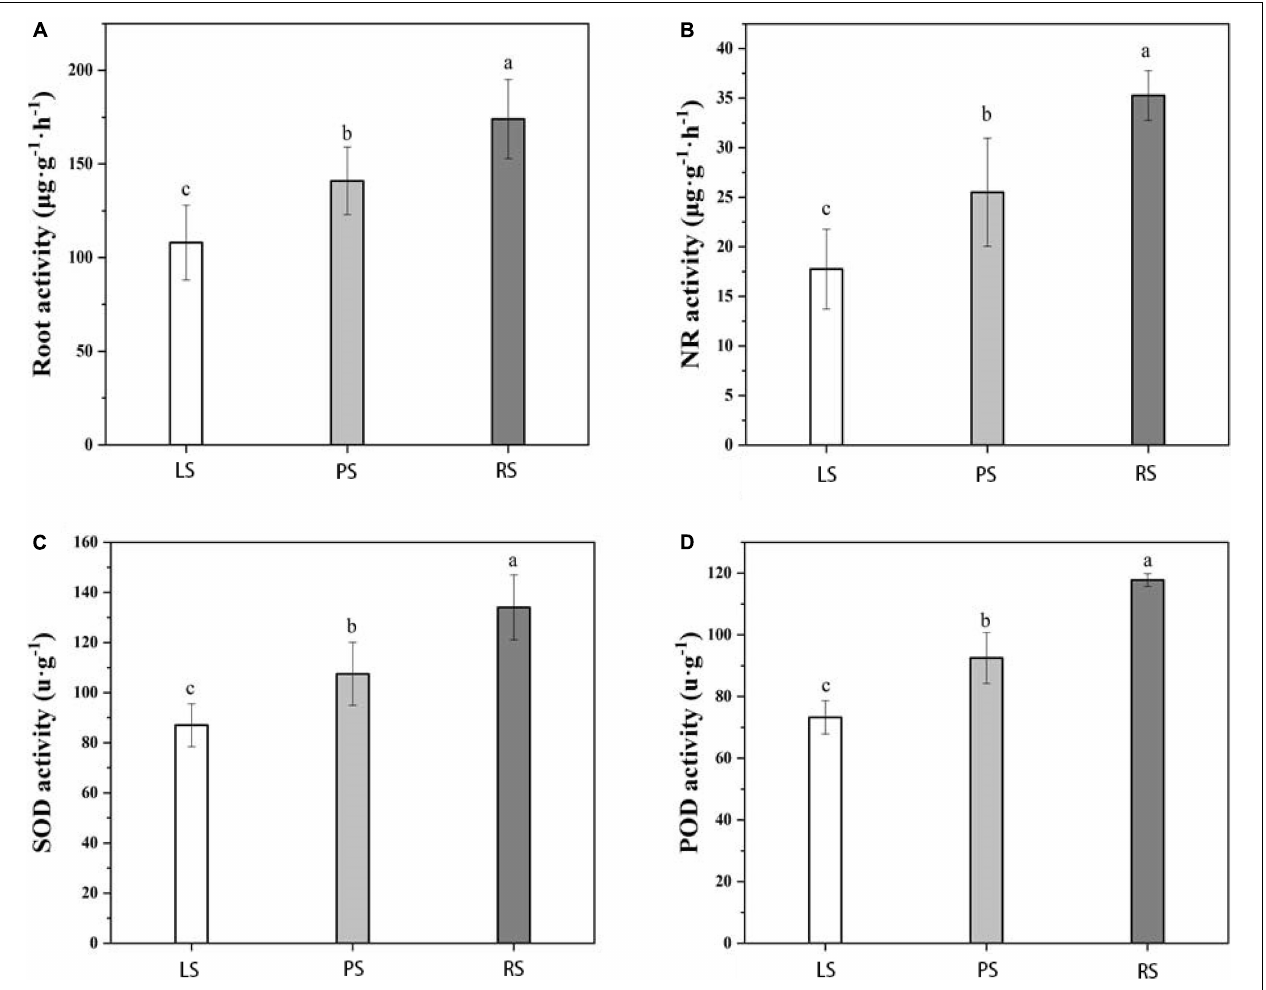
FIGURE 3 | Root physiological indices of flue-cured tobacco under different soil types. (A) Root; (B) nitrate reductase (NR); (C) superoxide dismutase (SOD); (D) peroxidase (POD); Duncan’s multiple-range tests; p < 0.05; LS, limestone soil; PS, paddy soil; RS, red soil. Different lowercase letters showed significant difference (P <